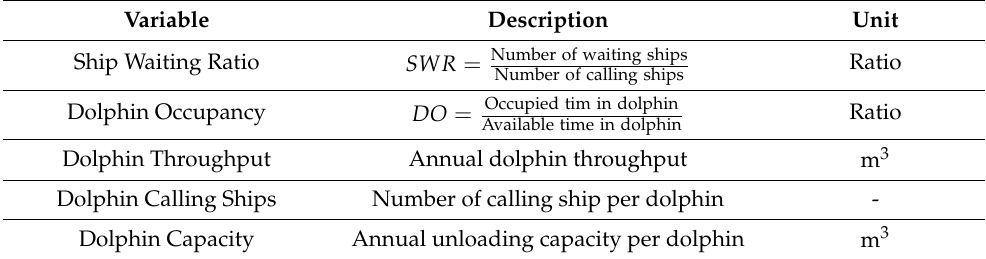
Table 3. Output variables for the simulation model.